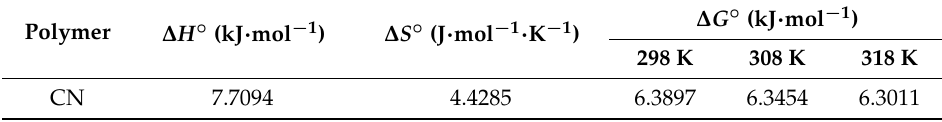
Table 4. Thermodynamic parameters for AMI adsorption by CN